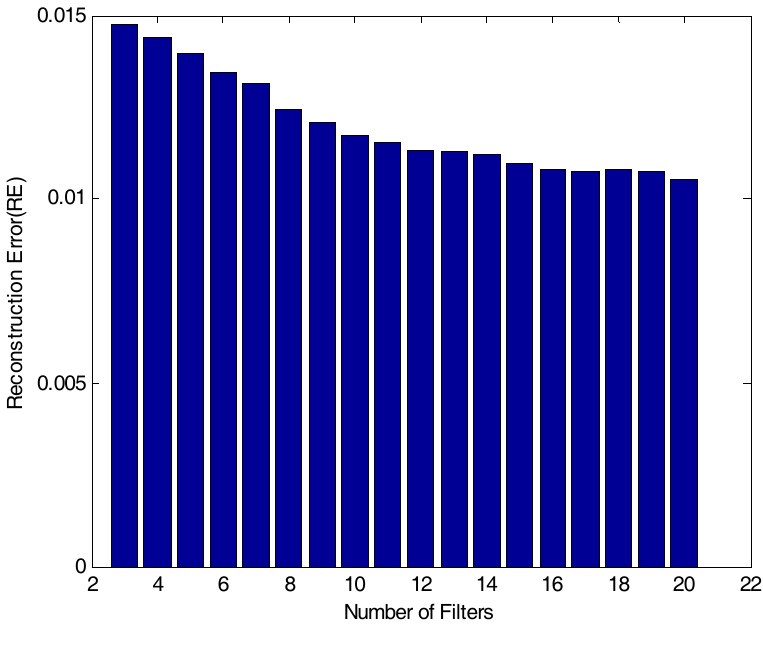
Figure 6. RE results to number of filters.